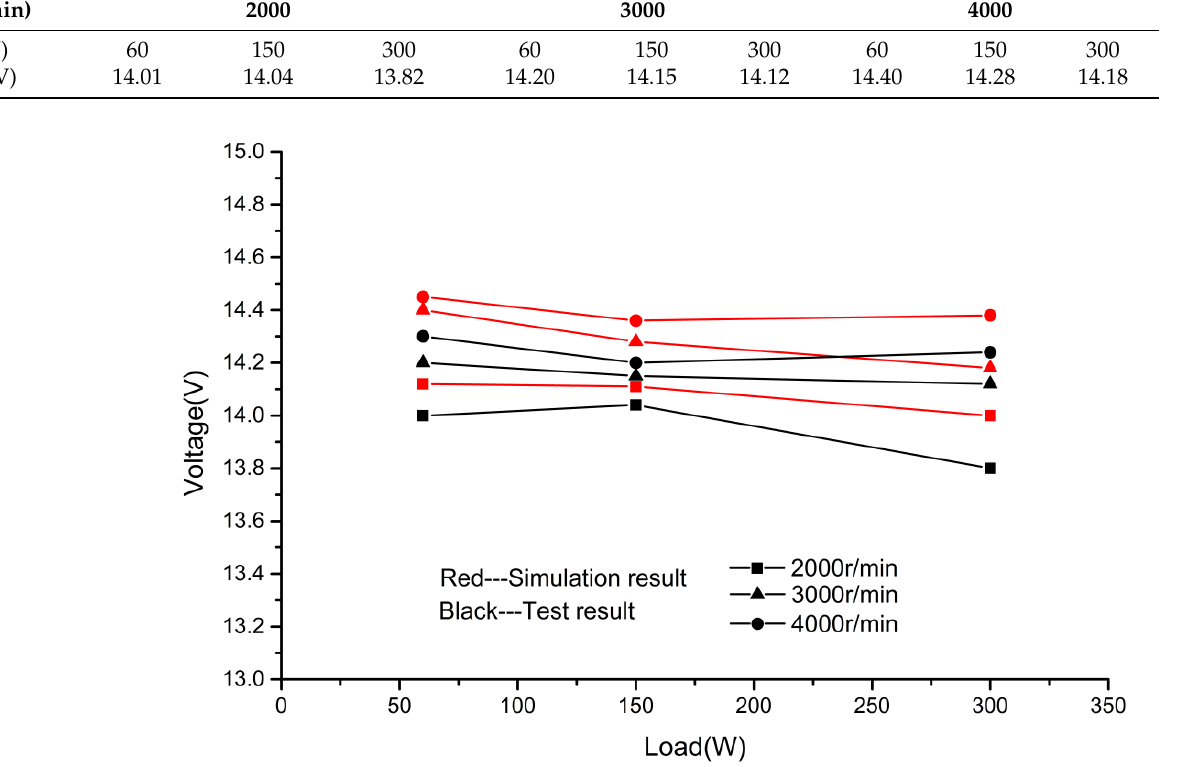
Figure 13. Comparison between simulation results and experiment results.